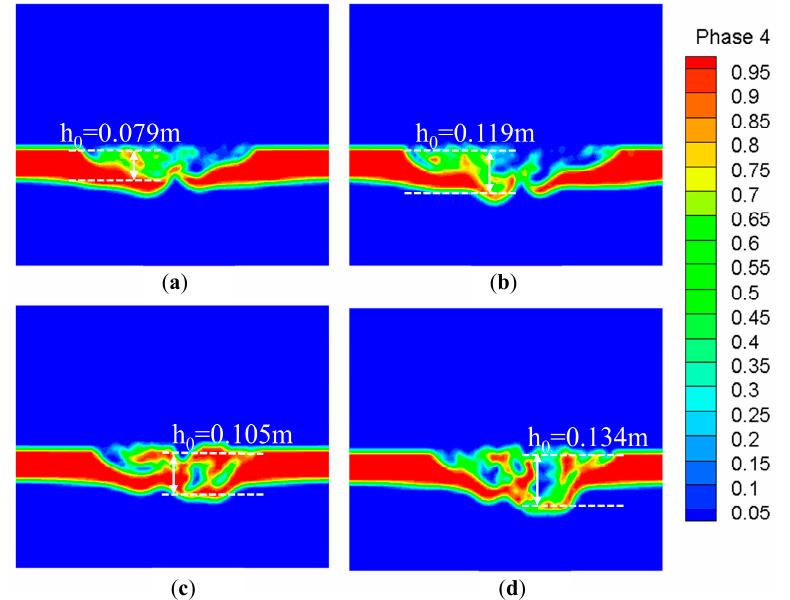
Figure 7. The local phase diagram: ( a ) The penetration depth of SA at t = 1 s; ( b ) The penetration depth of SA at t = 3 s; ( c ) The penetration depth of DA at t = 1 s; (d) The penetration depth of DA at t = 3 s.